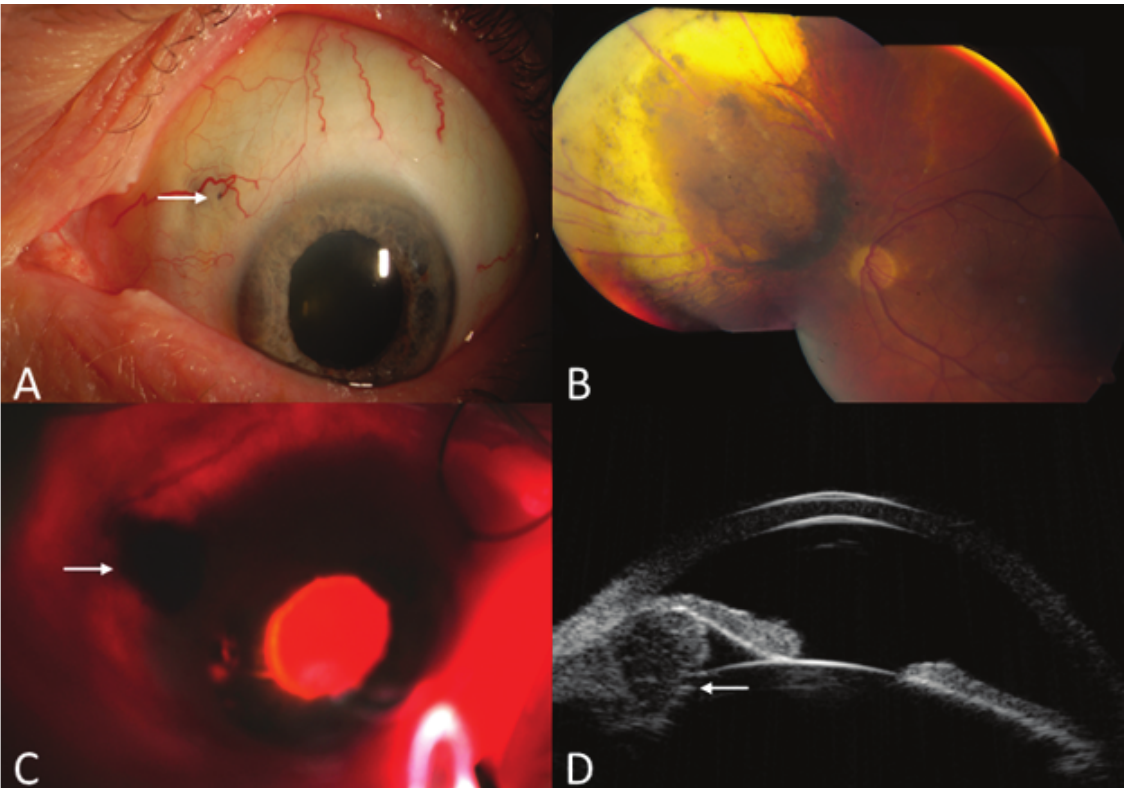
Figure 1. (A) Dilated episcleral blood vessel superonasally perforates the sclera 3mm from the limbus with a pigmented spot of extrascleral extension (arrow). Additional invasion of the peripheral iris is noted nasally. (B) Fundus photograph of the same eye shows irradiated choroidal melanoma with surrounding retinal pigment epithelium atrophy. (C) Transillumination demonstrates a dark shadow in the pars plana region (arrow). (D) Ultrasound biomicroscopy shows a ciliary body mass measuring 3.1mm in thickness with bowing forward of the peripheral